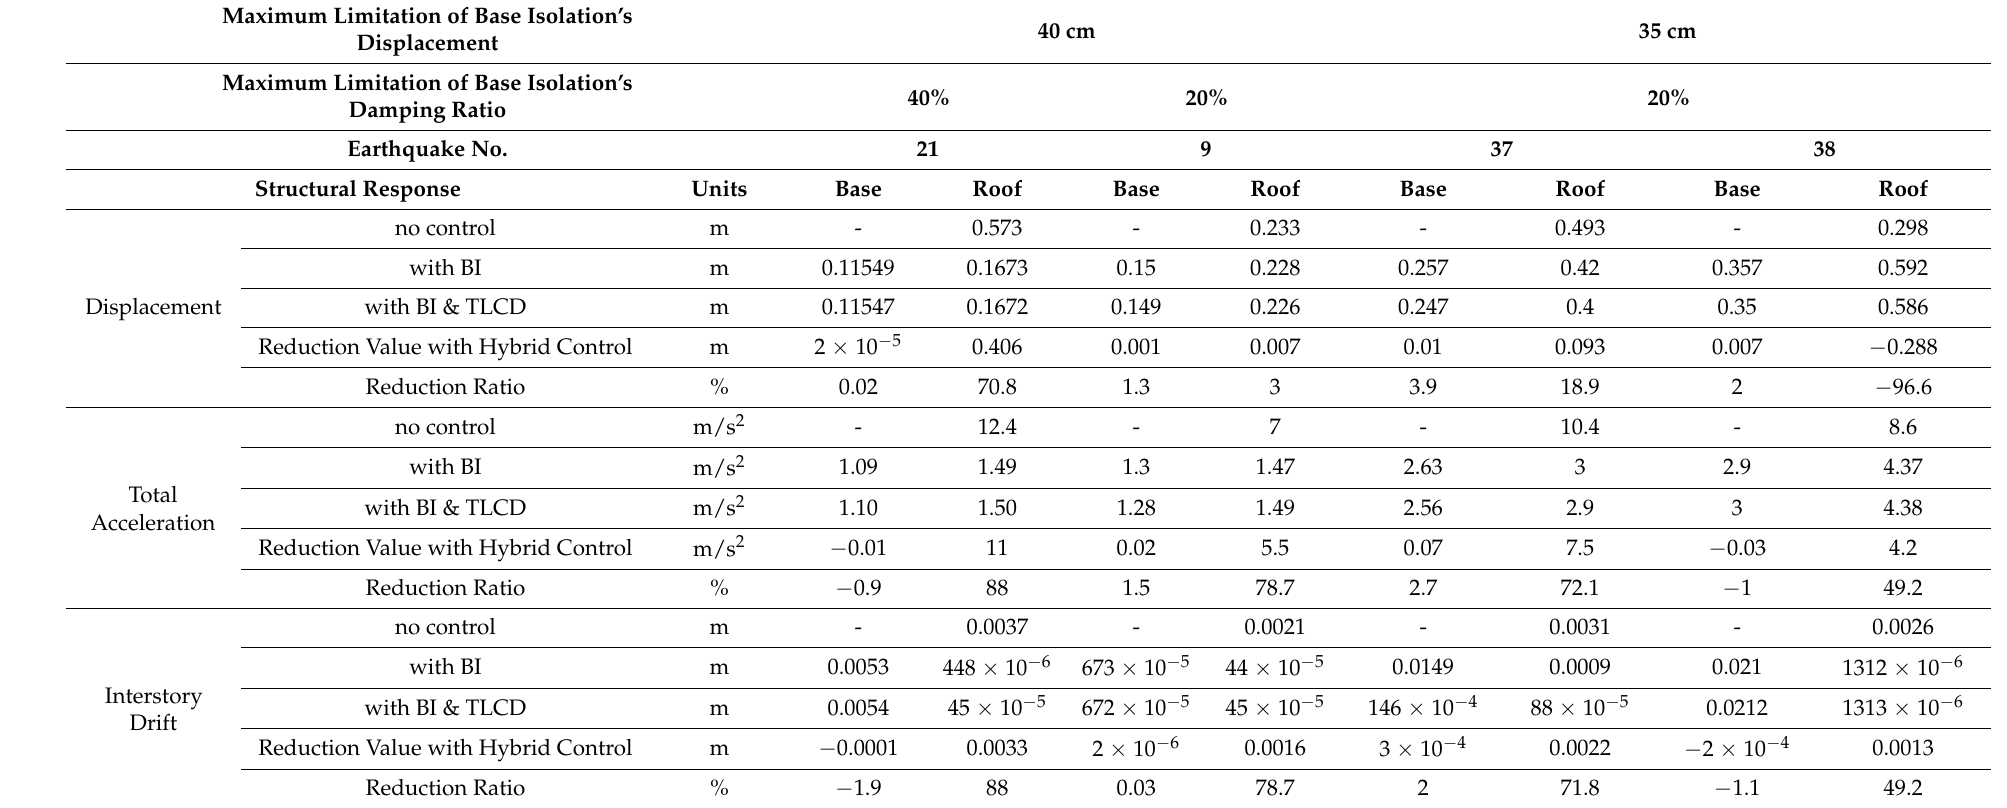
Table 4. Examples for the structural responses of base and roof